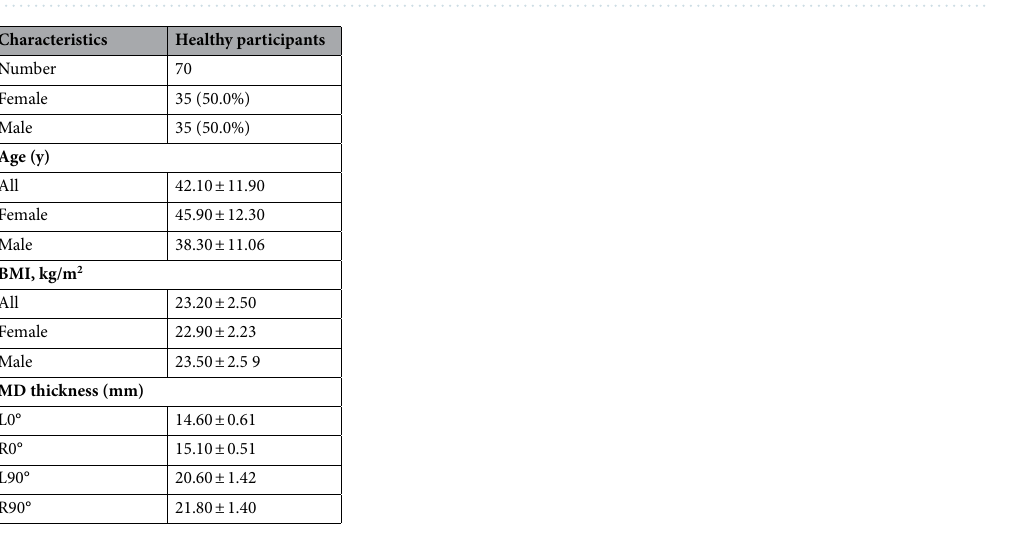
Figure 1. SWE (top panel) ultrasound images of the MD. A color map of MD elasticity is shown in the round Q-box (thin arrow) and square ROI (thick arrow). MD middle deltoid, SWE shear wave elastography, SWV mean shear wave velocity.